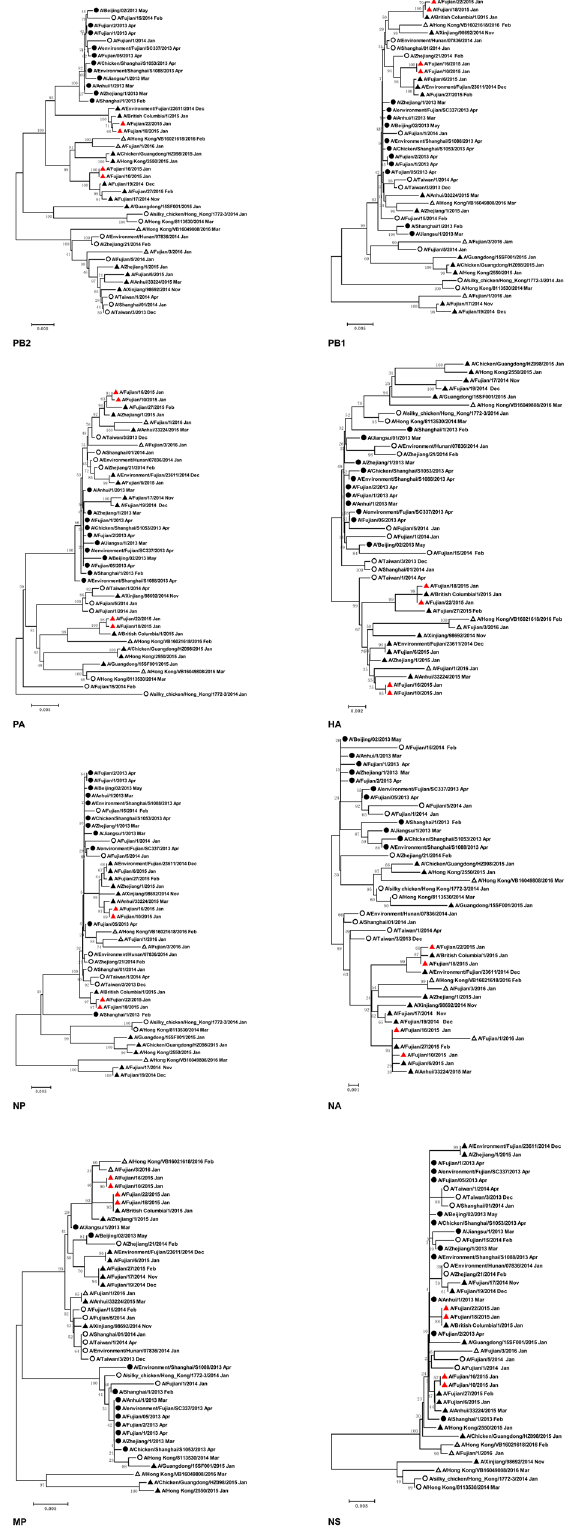
Figure 2. Phylogenetic tree of the complete genome of the H7N9 viruses isolated from two family clusters in Fujian province, Southeast China. H7N9 viruses isolated from the first, second, third, and forth epidemic waves of human infection with avian influenza A (H7N9) virus are marked with circles, open circles, triangles, and open triangles, respectively. The viruses isolated from the two family clusters are indicated by red